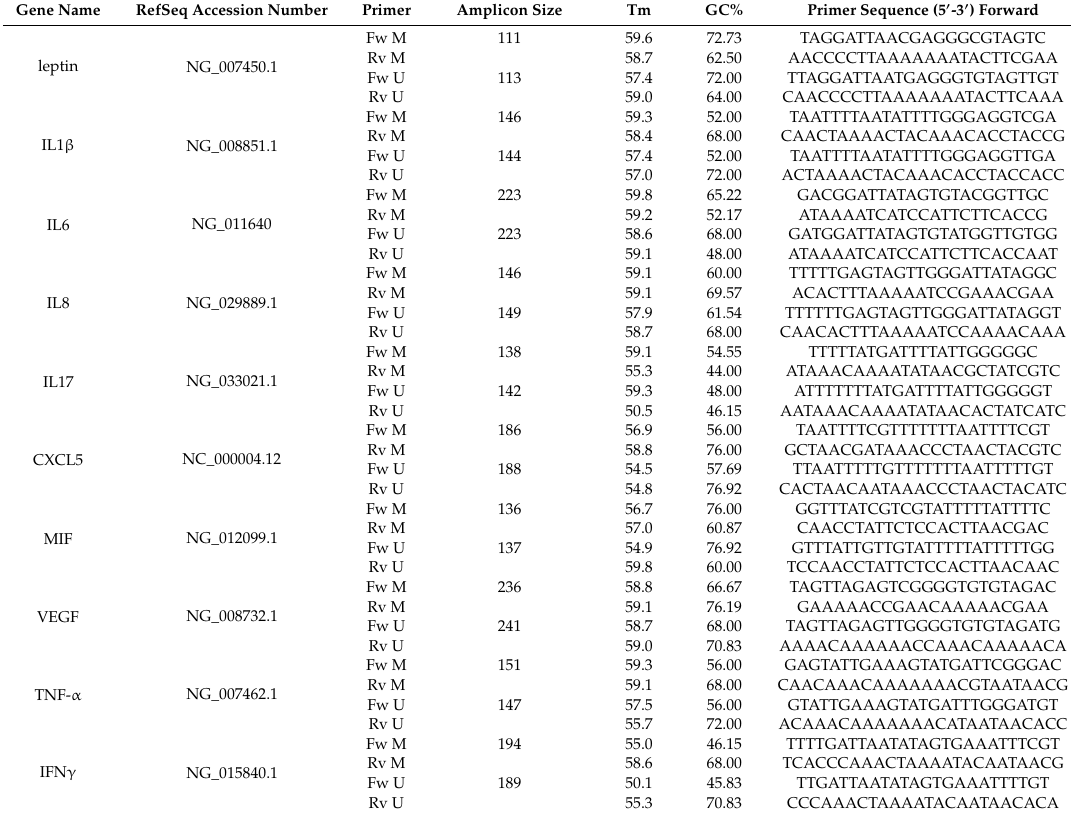
Table 2. Sequences of primers used for methylation-specific real-time